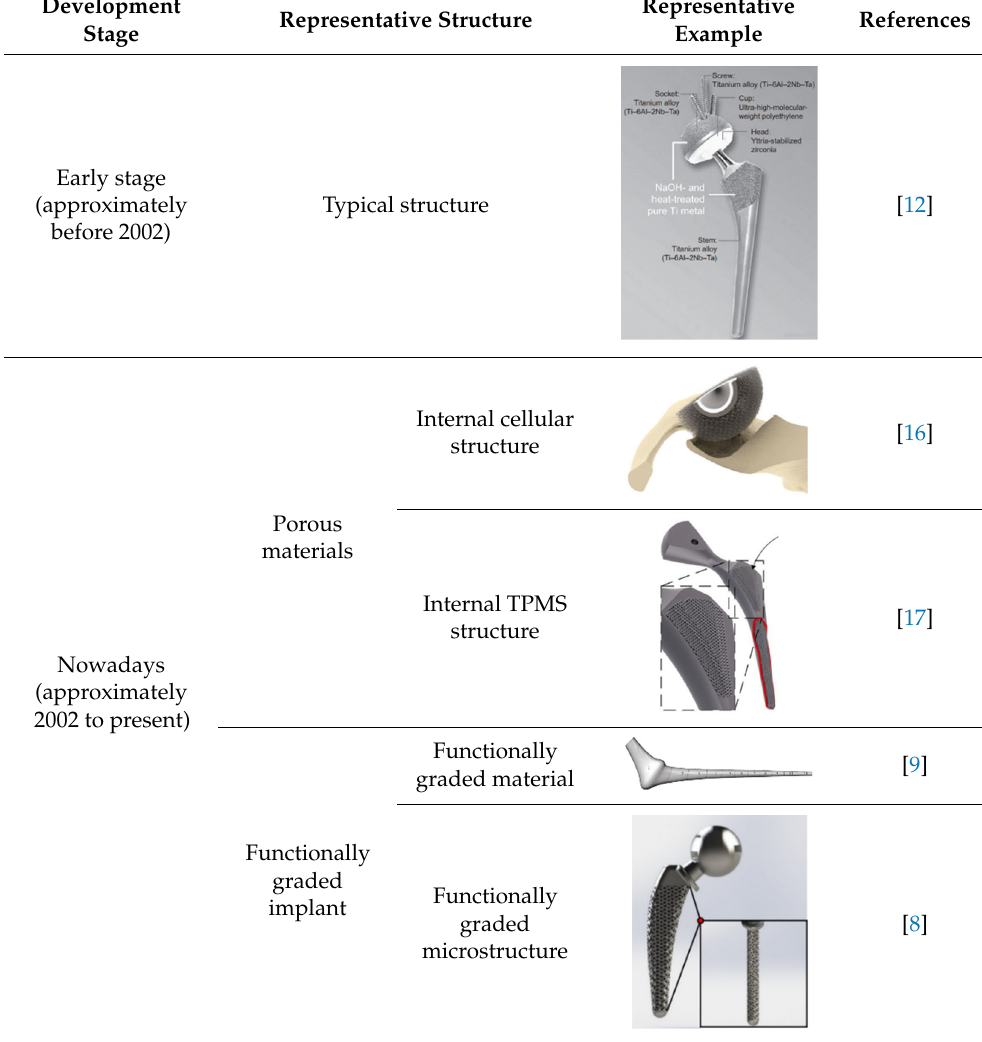
Table 2. Table 2. The evolution of hip joint replacements. Table 2. The evolution of hip joint replacements. Table 2. The evolution of hip joint replacements. Table 2. The evolution of hip joint replacements. Table 2. The evolution of hip joint replacements. Table 2. The evolution of hip joint replacements.